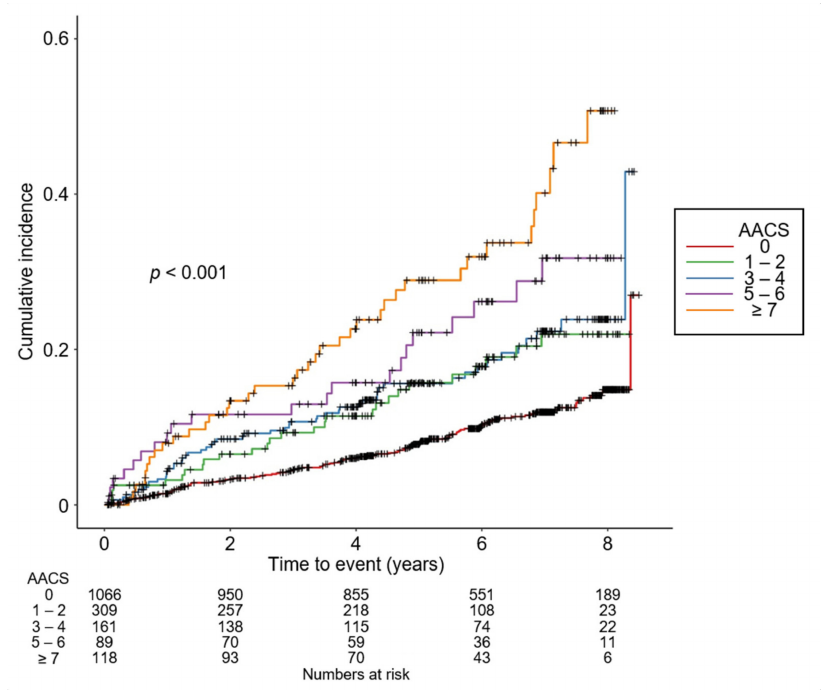
Figure 2. Kaplan–Meier curve for cumulative incidence of composite CV events by AACS. p value by log-rank test. Abbreviations: AACS, abdominal aortic calcification